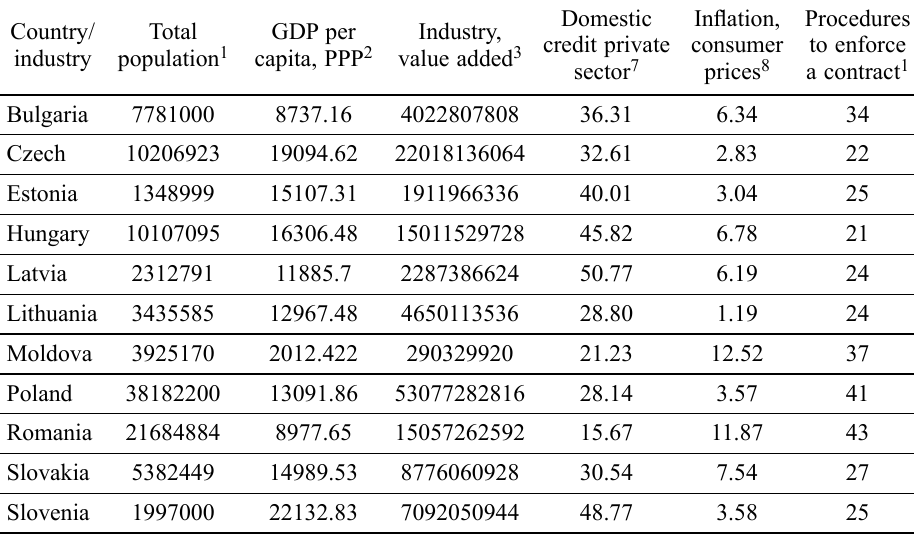
Table 1. Socio-economic and development indicators by country (2005) Country/